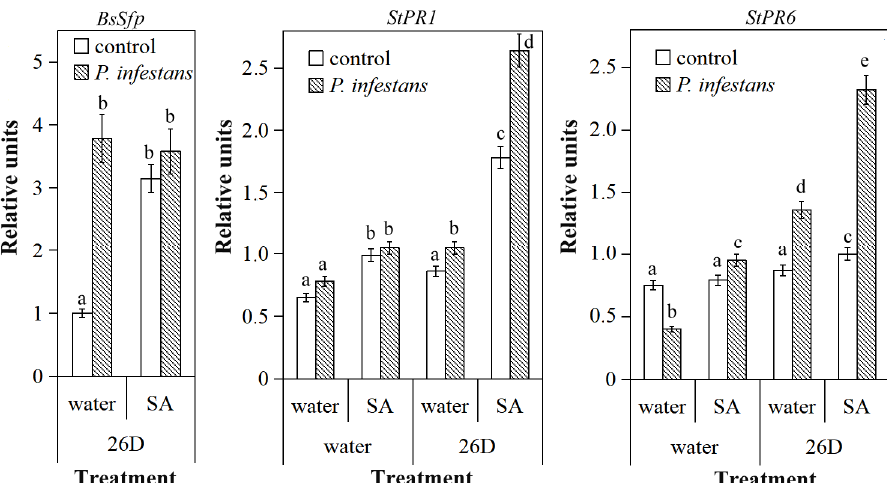
Figure 4. Influence of SA and B. subtilis 26D on the activity of transcription of the BsSfp gene (surfactin synthetase), potato genes StPR6 (trypsin inhibitor), StPR1 (basic protective protein) in potato plants 24 h after infection with P. infestans spores. The expression of each target gene is presented as a fold change normalized to the relevant reference gene. Values followed by the same alphabet are not significantly different from each other by Student test p < 0.05.